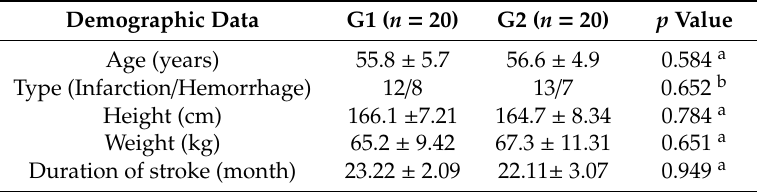
Table 1. The mean values of demographic data in both groups.